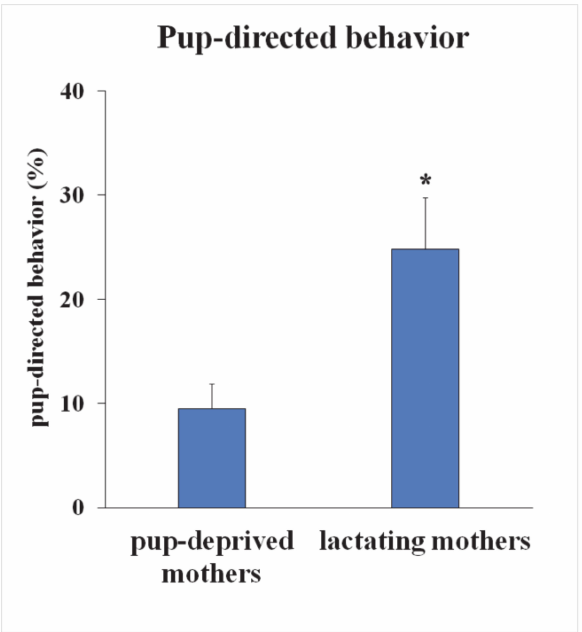
Figure 1. Pup-directed behavior of lactating and pup-deprived mothers. On the 10th day postpartum, maternal behavior of six lactating and six pup-deprived mothers was analyzed. Retrieval of pups, pup grooming, nest building, and sniffing of pups were considered as pup-directed behaviors. Pup- deprived mothers showed significantly decreased pup-directed behavior in the proportion of total time. (* = p <